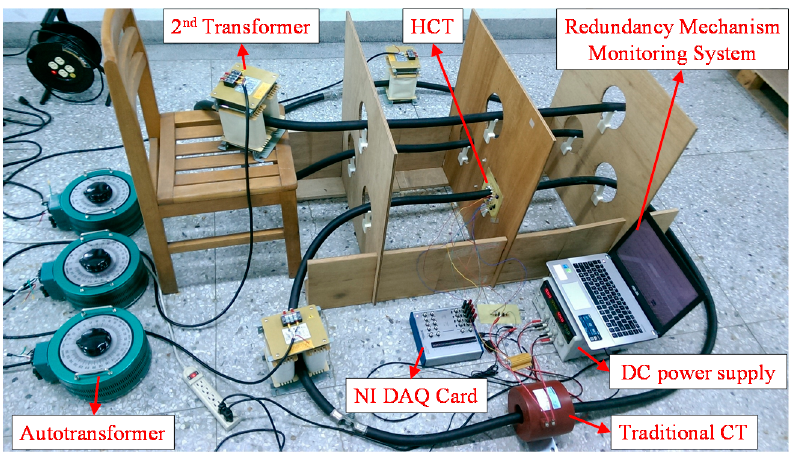
Figure 9. Measurement system framework.